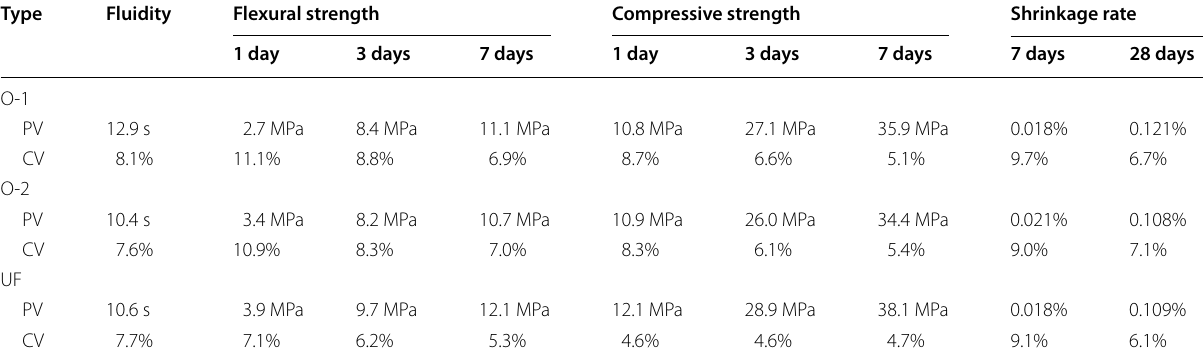
Table 11 Properties (PV) and coefficient of variation (CV) of different